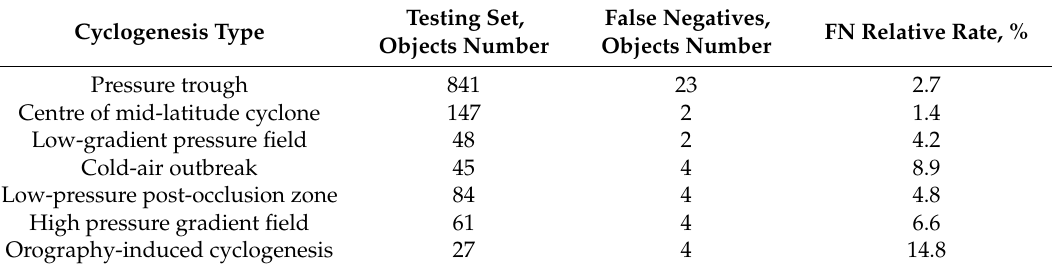
Table A2. False negative rates per cyclogenesis types.